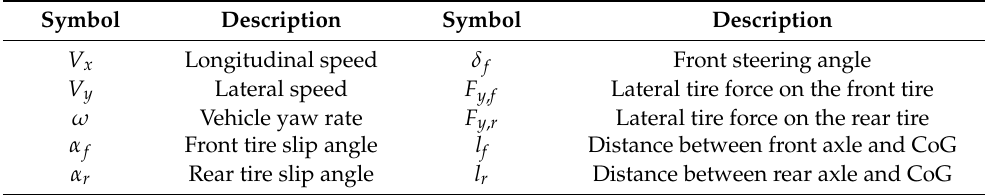
Figure 2. Vehicle model.